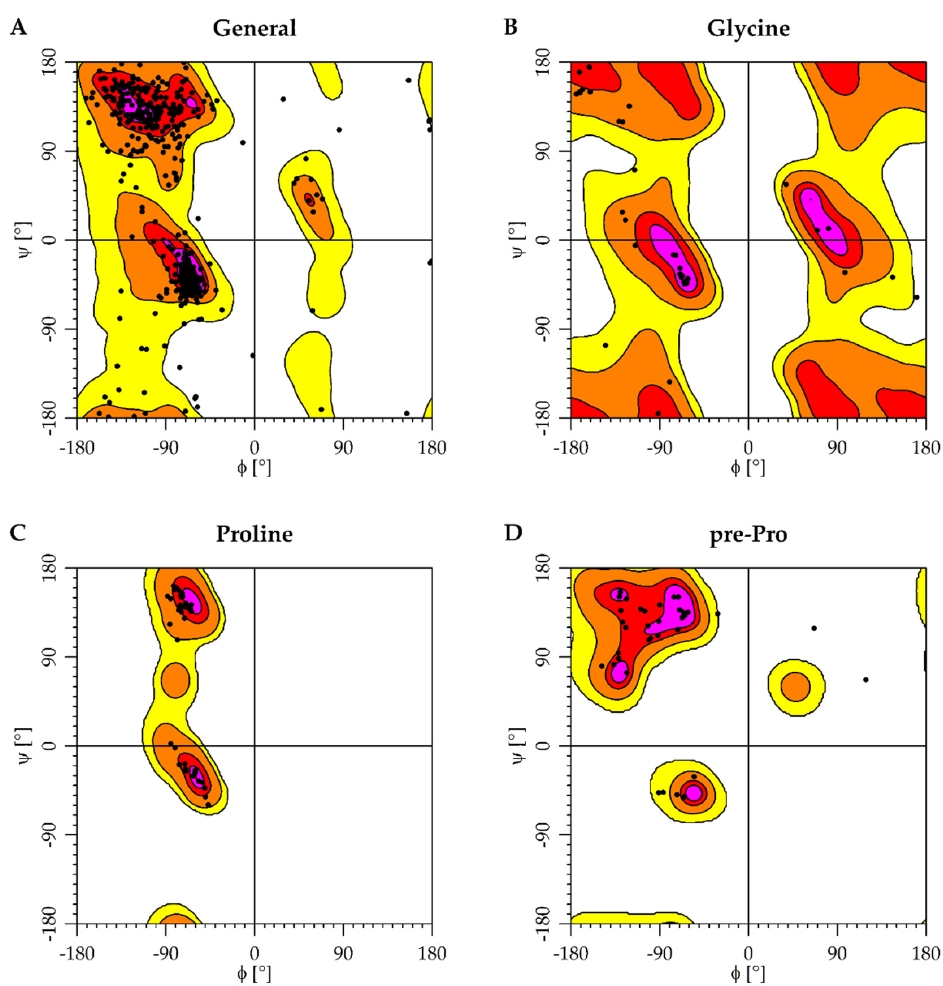
Figure 4. Detailed Ramachandran diagram of chains A and B of the α 7 nAChR homology model by residue type. ( A ) The general case of non-glycine, non-proline and non-pre-proline residues is depicted. The special cases having either significantly less ( B ; Glycine) or more conformational restraints ( C , D ; Proline and preproline). The contours of Glycine are twofold symmetrized based on the dataset from Lovell et al.